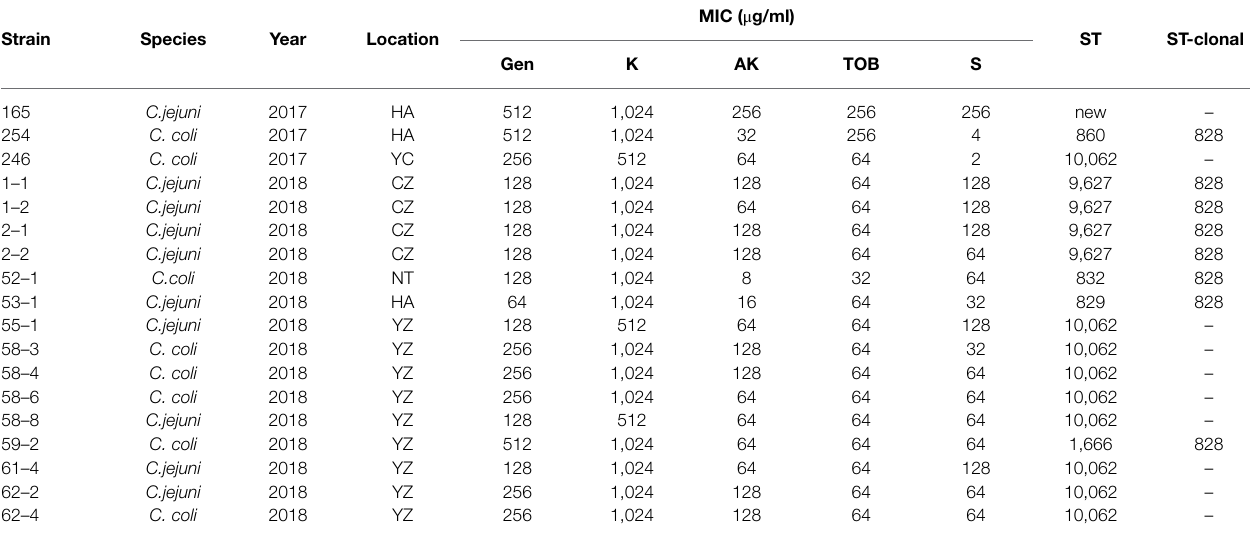
TABLE 4 | MICs of aminoglycoside antibiotics and STs for insertion-fragment positive